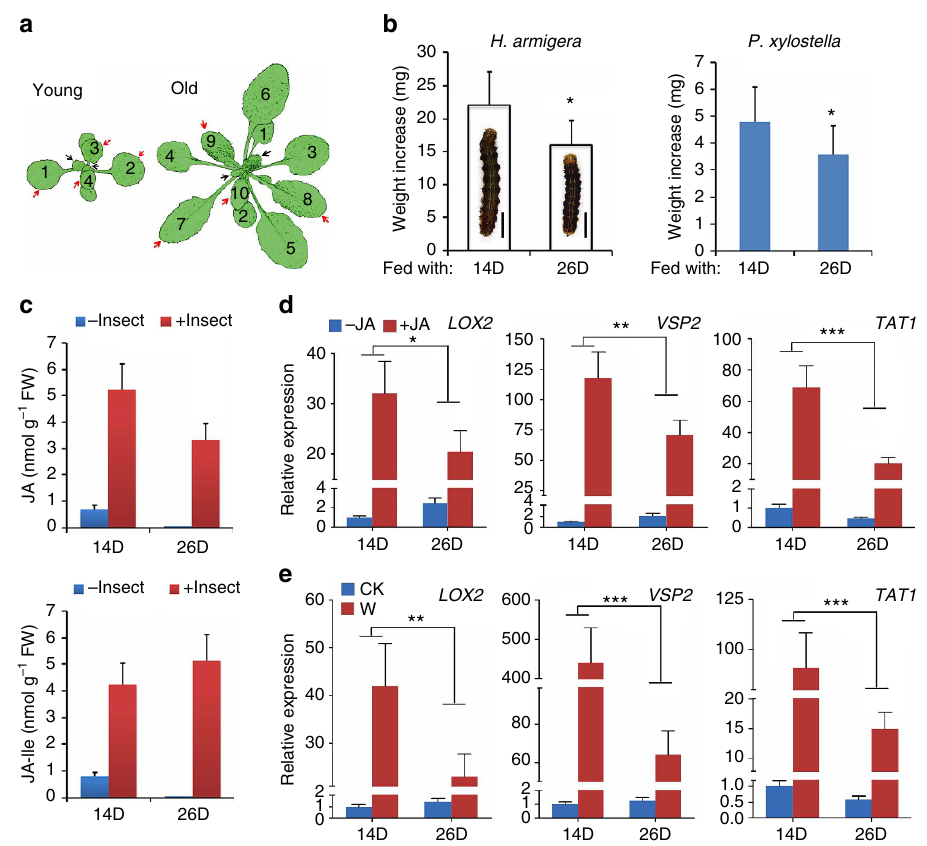
Figure 1 | Insect resistance enhances and JA response attenuates with plant age. ( a ) Diagrams of young (14-day-old, 14D) and old/adult (26-day-old, 26D) plants of Arabidopsis thaliana (Col-0) grown in LD. Black arrows indicate the newly initiated leaves (new leaves, B 3mm in width), and red arrows indicate the rapidly expanding leaves. ( b ) Weight increase of H. armigera and P. xylostella larvae fed with rapidly expanding leaves harvested from the indicated plants for 3 days, both gained less weight from the old (26D) plants. Data are means ± s.d. ( n ¼ 25), asterisk indicates significant difference from the 14D group (Student’s t -test, * P o 0.05). Embedded in the column is the image of the H. armigera larva after feeding. Scale bar, 1cm. ( c ) Analysis of JA and JA-Ile contents in young (14D) and old (26D) plants by UPLC-MS. Plants were challenged by H. armigera third instar larvae for 12h and the rapidly expanding leaves were collected for analysis. Intact plants were used as control. Data are means ± s.d.( n ¼ 3). ( d , e ) Expression of LOX2 , VSP2 and TAT1 in young (14D) and old (26D) plants in LD. Transcript levels were detected by qRT-PCR. Data were analysed by multiple comparisons (Tukey test) followed by two-way ANOVA (* P o 0.05, ** P r 0.01, *** P r 0.001). Error bars represent ± s.d. ( n ¼ 3). ( d ) Gene expressions in total aerial tissues of young (14D) and old (26D) plants 4h post-MeJA treatment, the JA response attenuated with plant age. The expression in the 14D control plants ( (cid:2) JA) was set to 1. ( e ) Gene expressions in rapidly expanding leaves of the young (14D) and the old (26D) plants 2h post-wounding (W) treatment, the wounding response attenuated with plant age. The expression in the 14D intact plants (CK) was set to 1. ANOVA, analysis of variance; UPLC-MS, ultra performance